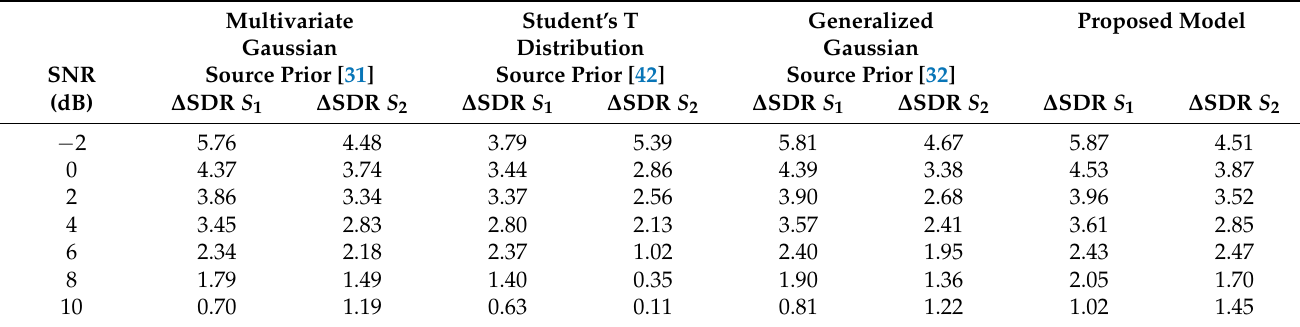
Table 3. Average SNR results for the second proposed model shown in Figure 2 with variable SNR for multistage BSS models having different source priors.